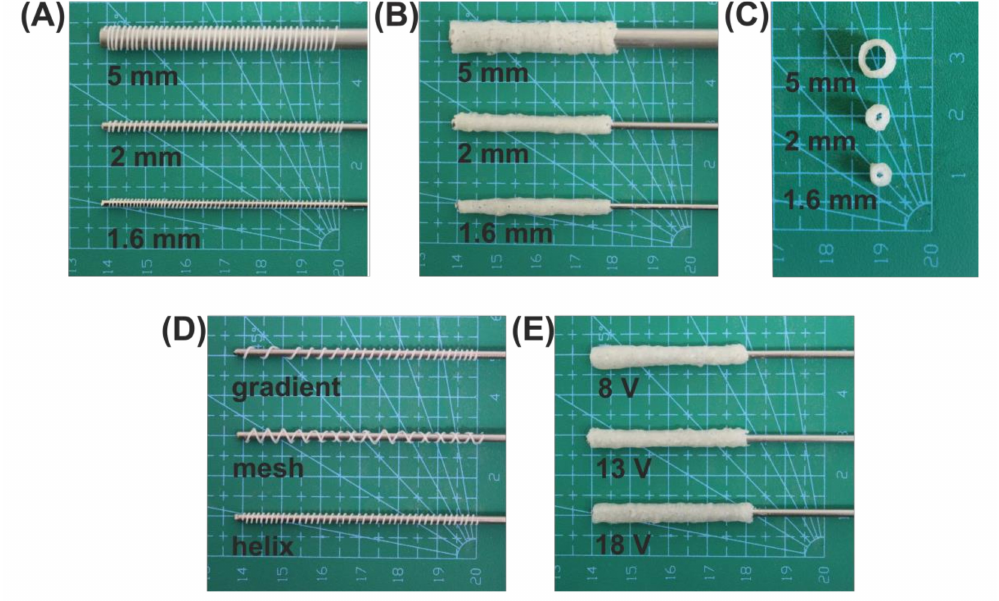
Figure 2. ( A ) Build plate of different diameters with the printed PCL skeleton. ( B ) Longitudinal view and ( C ) transverse cross-section of hybrid implants. ( D ) Exemplary shapes of the PCL skeleton. ( E ) Hybrid implants obtained for the electrodeposition process initiated at different